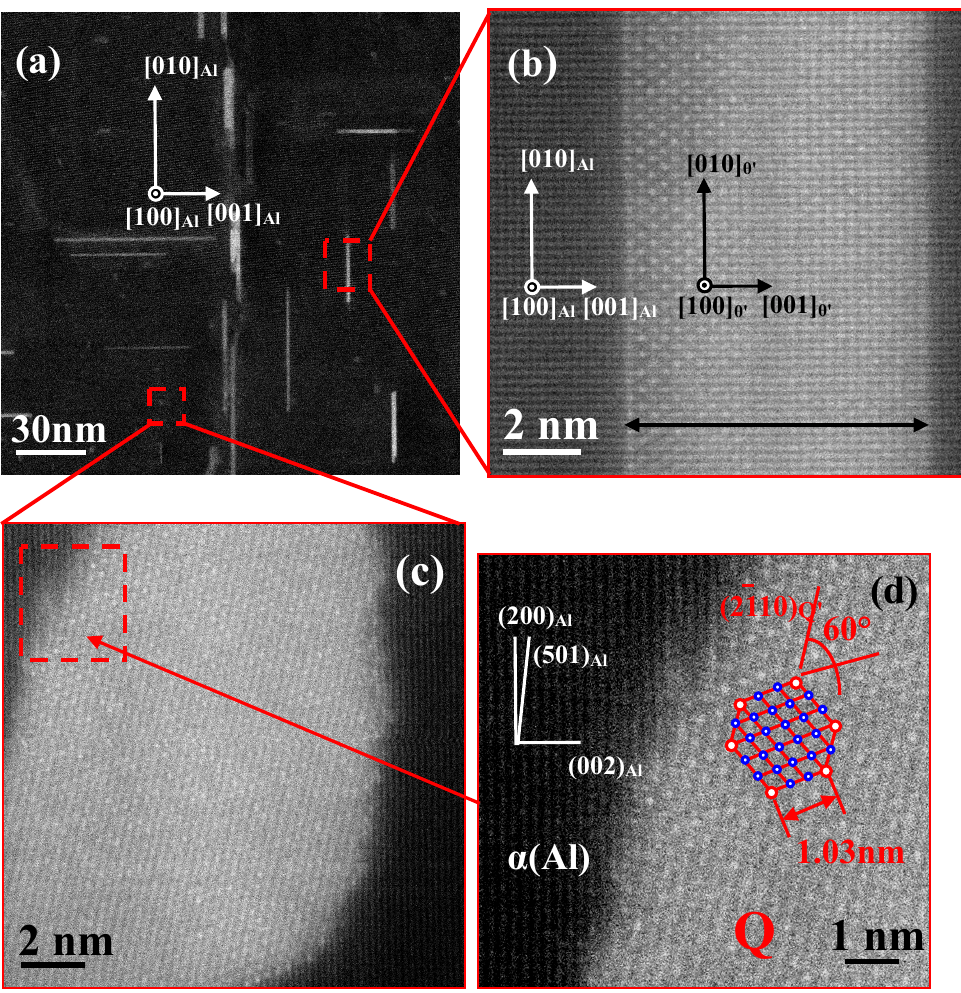
Figure 18. High-resolution HAADF-STEM images of Alloy 4 (165 °C/960 min) observed via the <010> Al zone axis. ( a ) The lamellar θ ’ precipitates; ( b ) Z-contrast image of the θ ’ phase; ( c ) the granulated Q’ precipitate; ( d ) Z-contrast image of the Q’ phase.